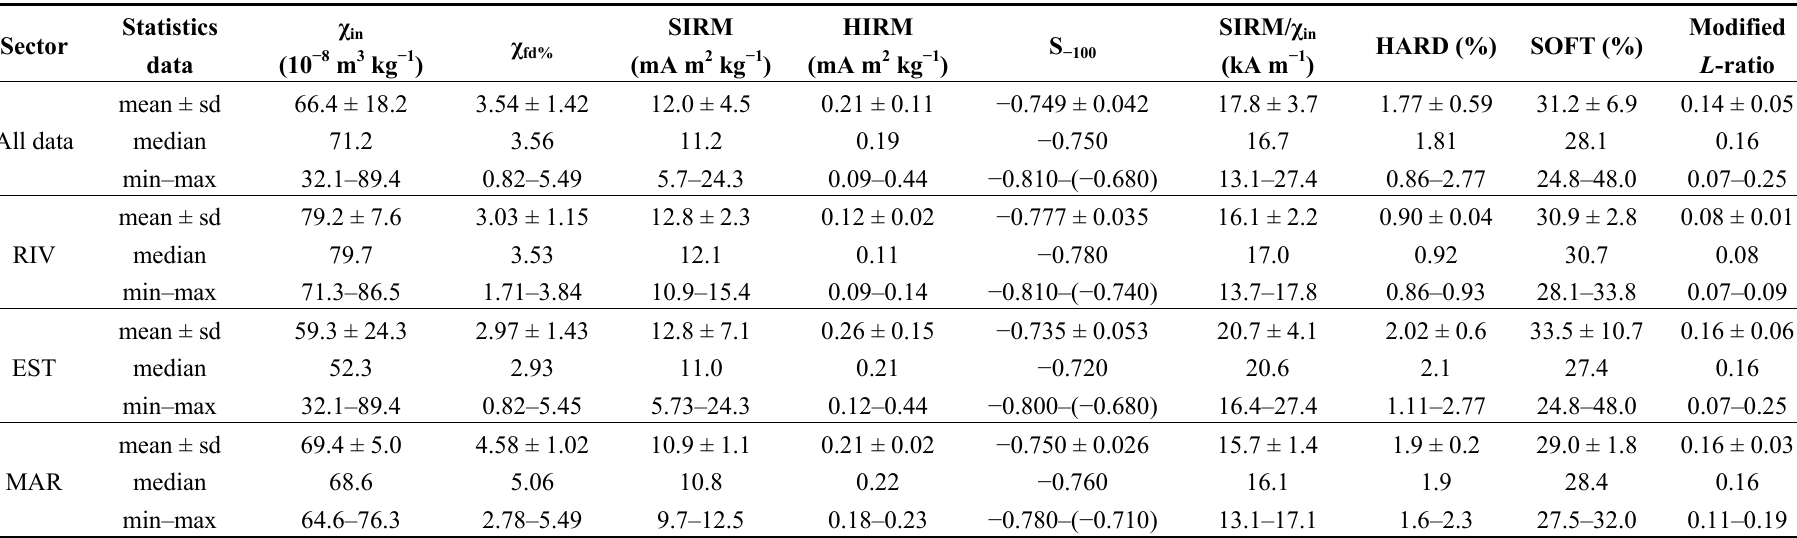
Table 4. Summary statistics data of magnetic parameters in sediments of the riverine (RIV), the estuarine (EST) and the marine (MAR) sectors of the Asopos River